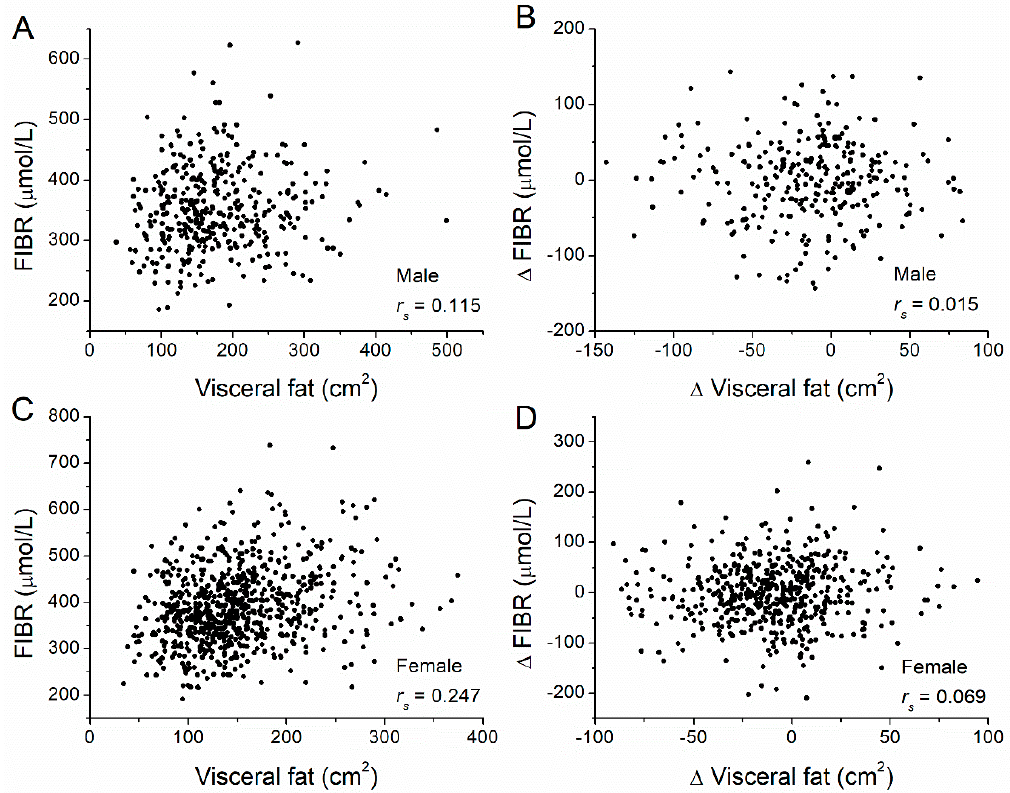
Figure 3. Correlations between visceral adipose tissue (VAT) volume and FIBR levels, and between their changes. Correlations between ( A ) VAT and the FIBR level ( r s = 0.115, p = 0.024), and between ( B ) changes in VAT and changes in FIBR levels ( r s = 0.015, p = 0.804) in male participants of the diabetes prevention program. Correlations between ( C ) VAT and the FIBR level ( r s = 0.242, p < 0.001), and between ( D ) changes in VAT and changes in FIBR levels ( r s = 0.069, p = 0.111) in female partici- pants. Adipose tissue volume was measured at baseline and the one-year follow-up by computed tomography at the L4–L5 level. Δ = value (year 1) − value (baseline) , where values correspond to fat volume or FIBR. The Spearman’s rank correlation coefficient, r s , was calculated.